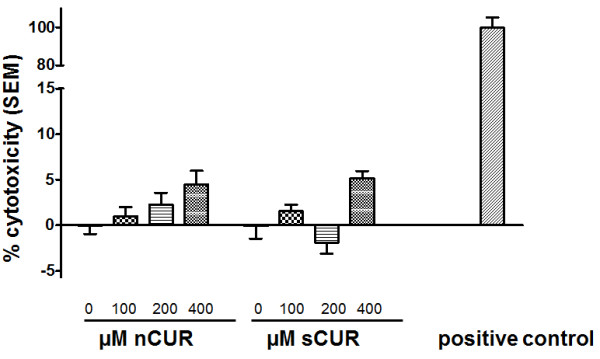
Cytotoxicity of CUR for Detroit 562 cells. Cytotoxicity assay. Monolayers of Detroit 562 cells were exposed to various concentrations of nCUR or sCUR, respectively, as indicated. The proportion of toxicity is indicated as mean + 1 SEM of three consecutive experiments run in triplicate, i.e., 9 data points per condition were tested. The positive control was provided by the manufacturer of the kit and led to complete cell lysis (defined as 100% lysis).